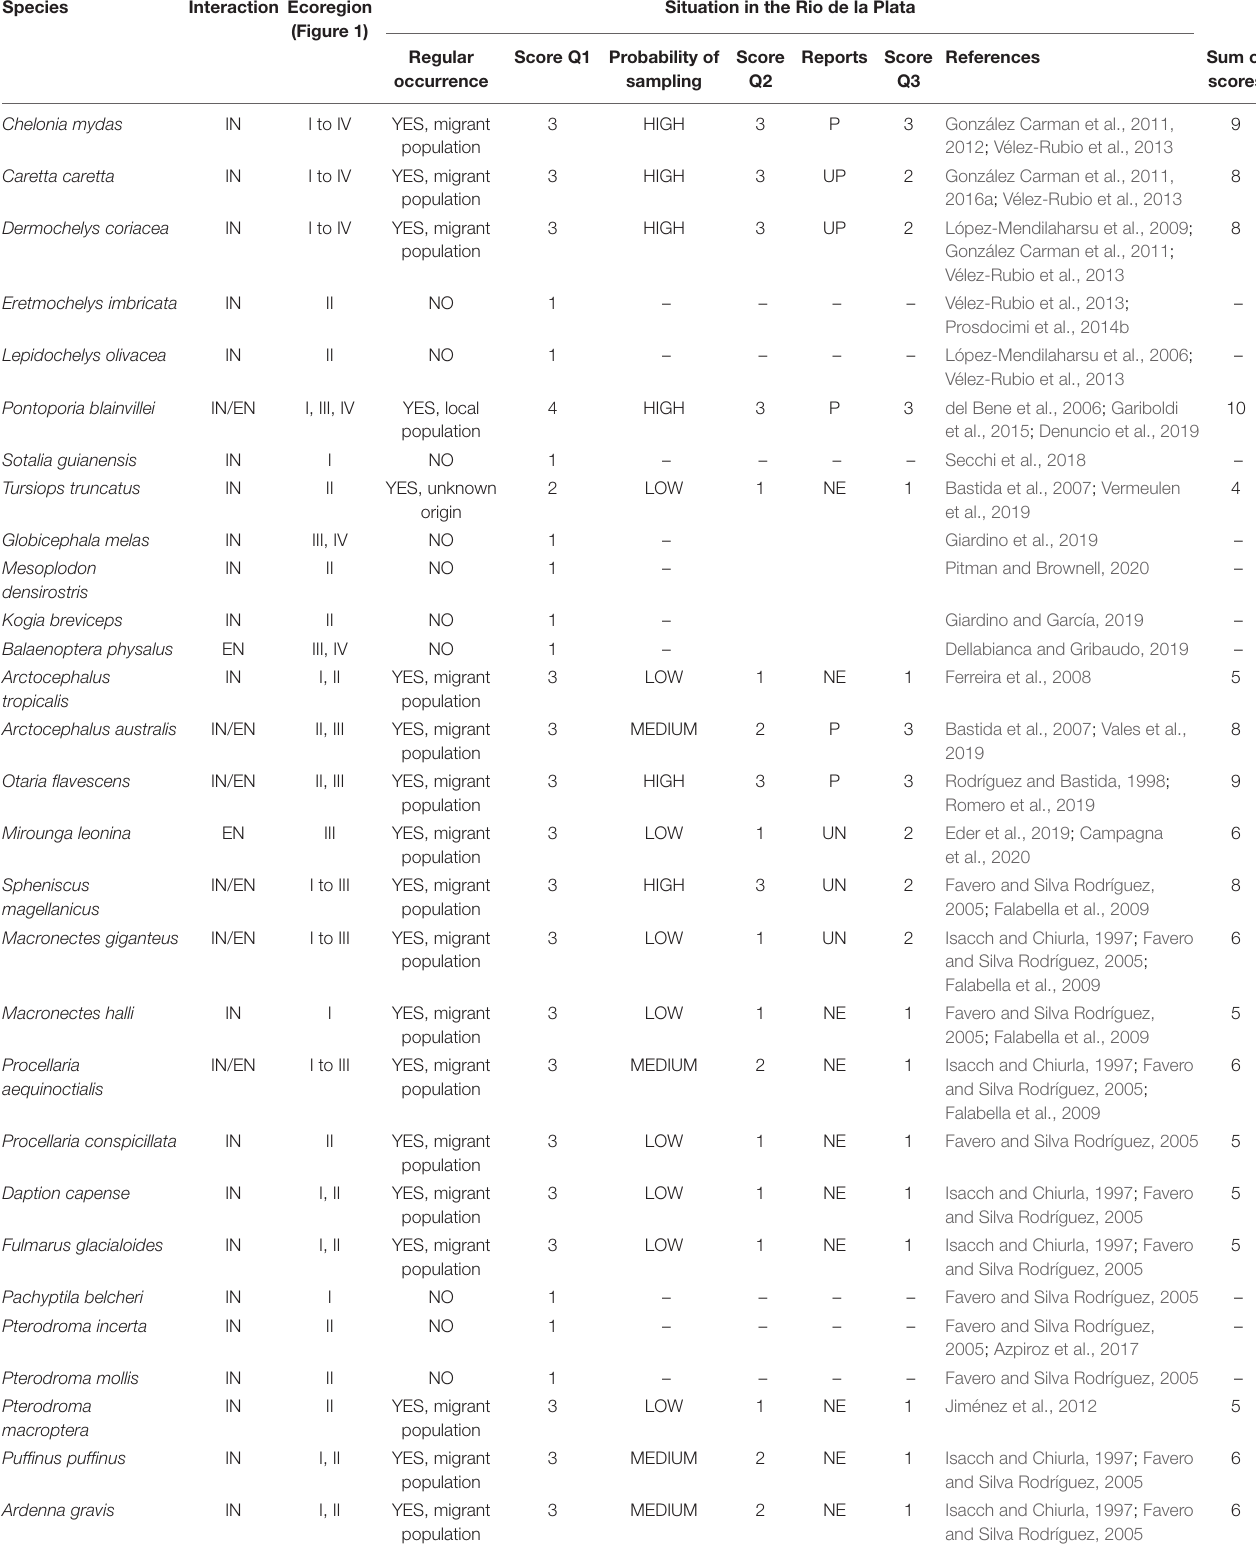
TABLE 2 | Species that interact with plastics in the Warm Temperate Southwest Atlantic and their occurrence in the Río de la Plata estuarine area. Species Interaction Ecoregion (Figure